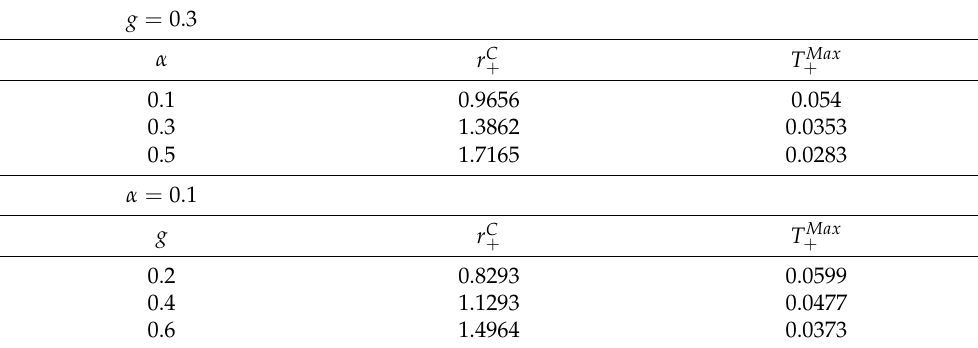
Table 2. The critical radius ( r c + ) with corresponding maximum temperature ( T Max + ) of 4 D nonsingular EGB black hole for different values of α and g